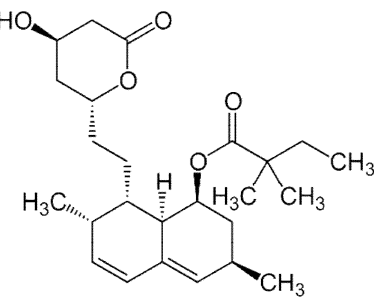
Figure 2. Chemical structure of simvastatin molecule according to the open-access data of ref. [69].